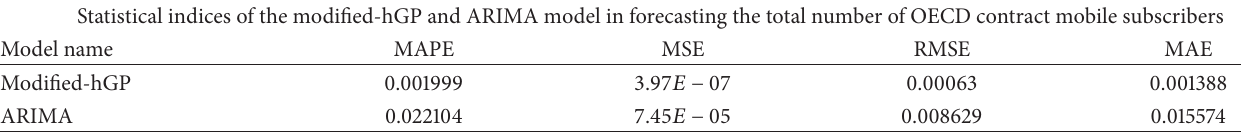
Table 12: Statistical indices in forecasting process of the modified-hGP and ARIMA model for the total number of OECD contract mobile subscribers.